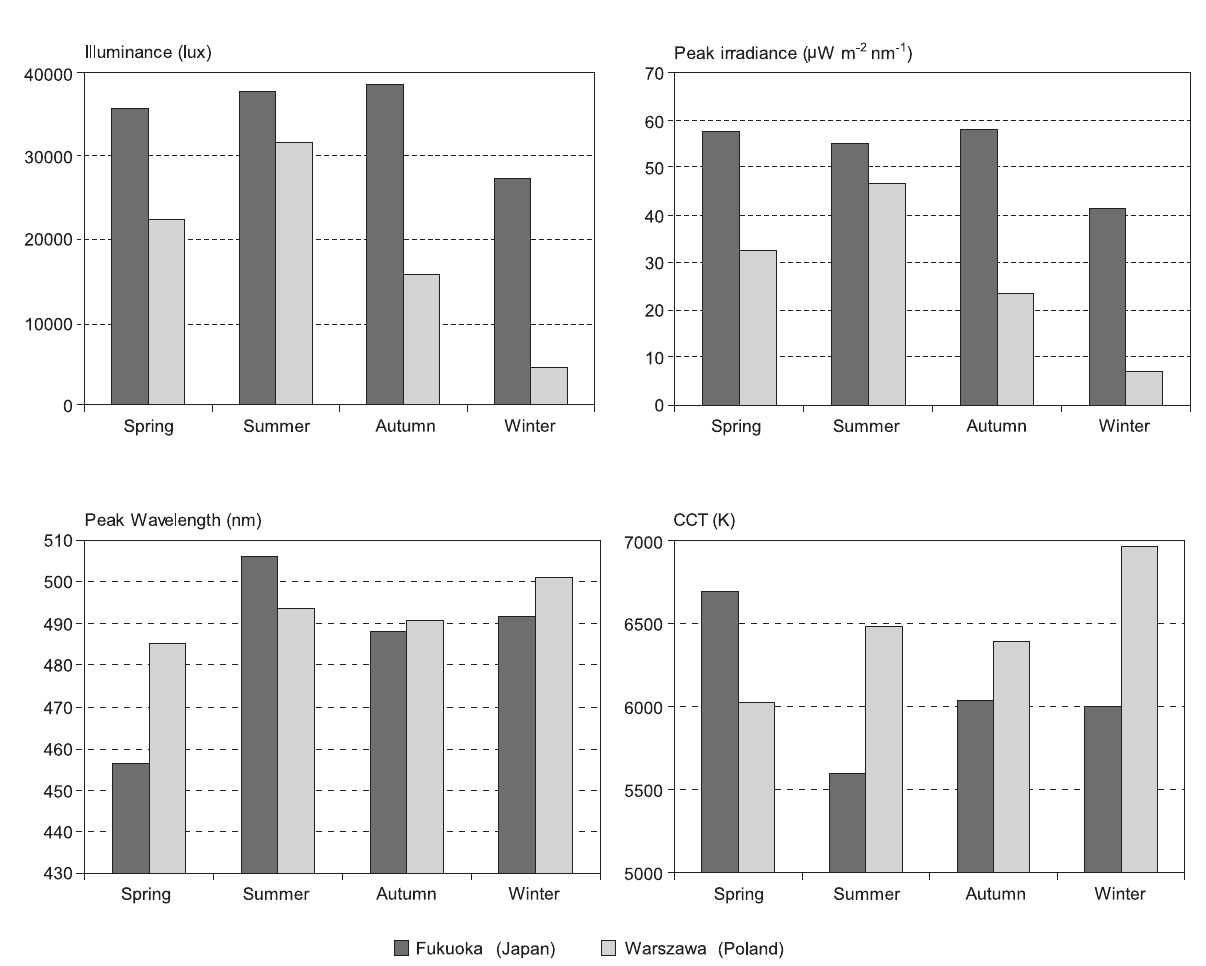
Fig. 2. Spectral characteristics of light (illuminance, peak irradiation, peak wavelength, colour corresponded temperature – CCT) registered in particular seasons in studied regions